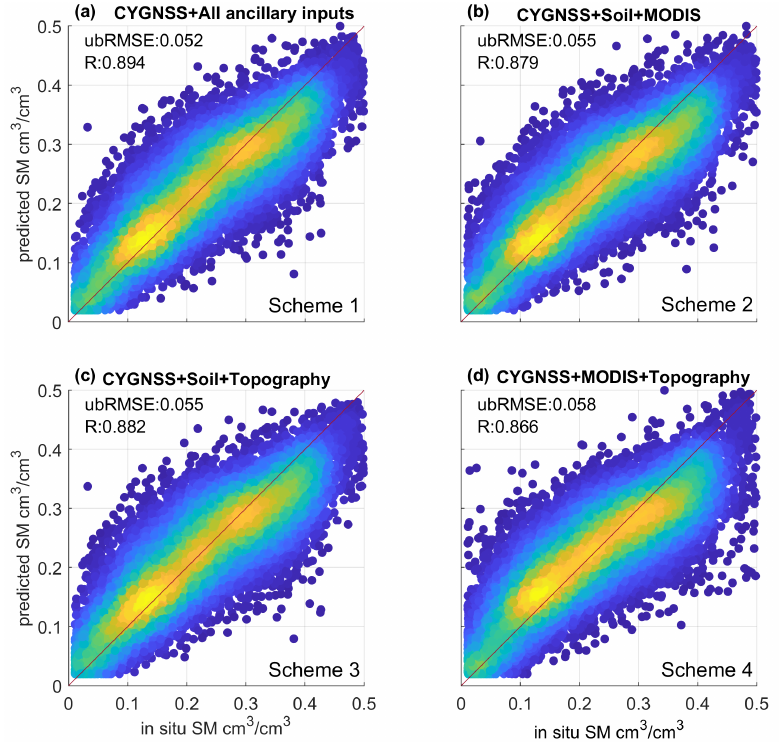
Figure 4. Scatter plots of the predicted SM estimates versus in-situ SM observations for ML models with different input feature groups. The input features are described in Table 2. Color of scatter points indicates the density of data points where yellow means a dense data sampling.